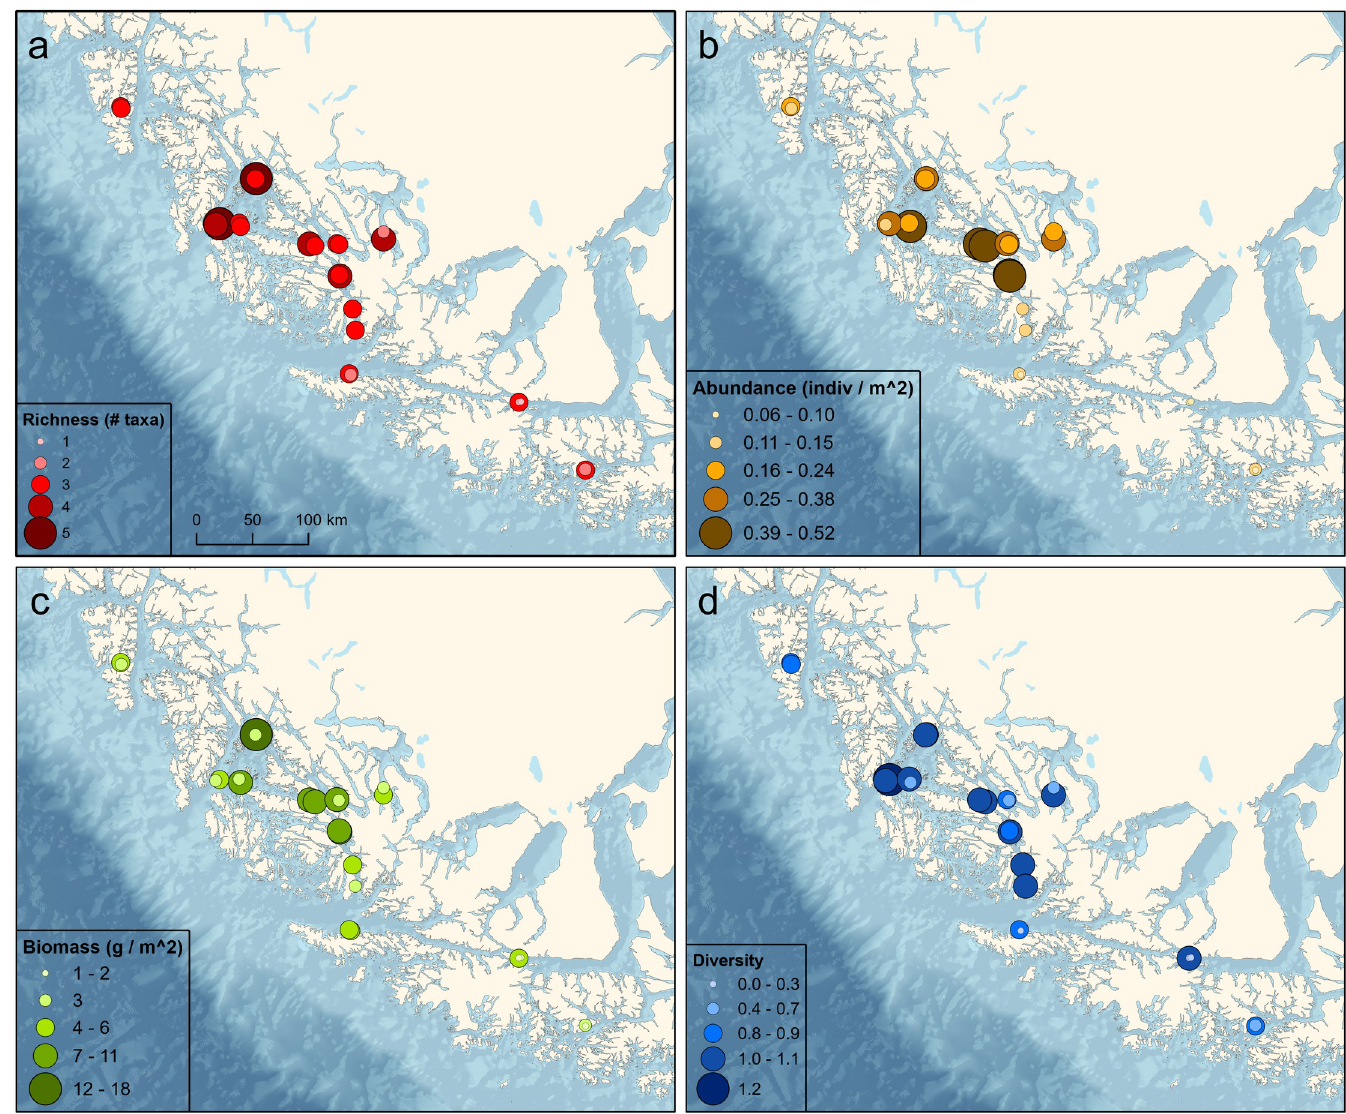
Fig 6. Fish assemblage characteristics among sampling locations. A. Species richness, b. number of individuals m -2 , c. biomass (g m -2 ), d. Shannon-Weaver Diversity Index.